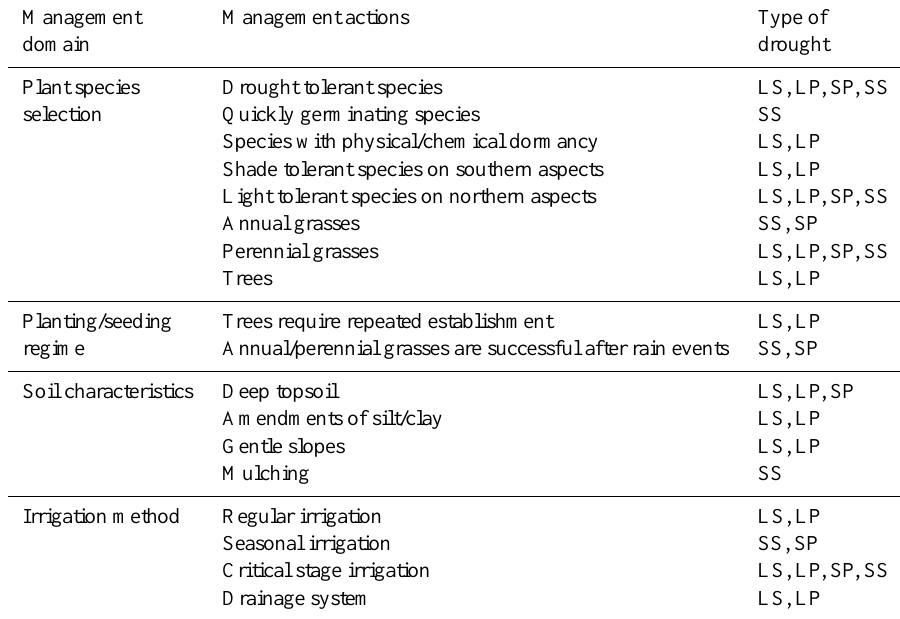
Table 3. Management actions for addressing specific kinds of drought characteristics identified with SDF curves for the southern